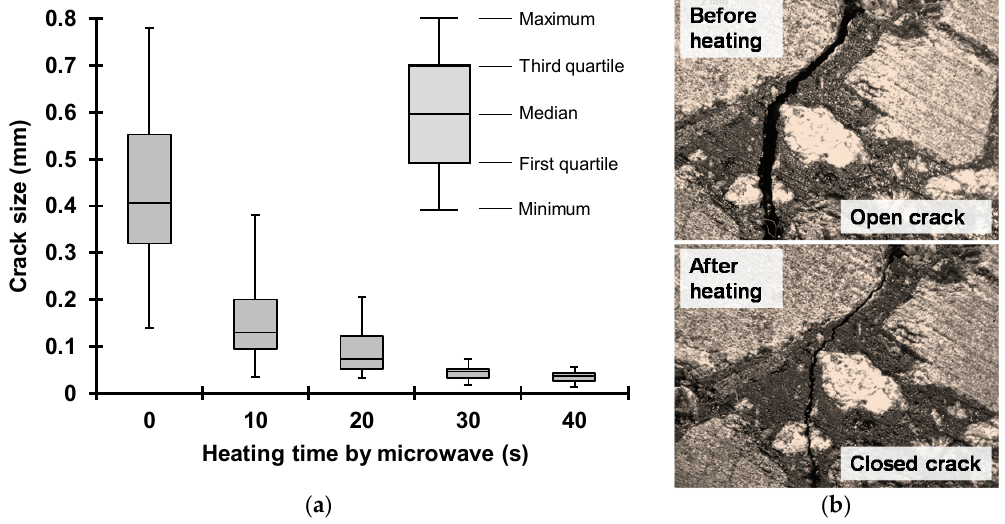
Figure 11. ( a ) Box plot representation of the crack size before healing (heating time = 0 s) and after healing of asphalt mixture samples at different heating times; ( b ) Optical images of a cracked asphalt sample before and after heating by microwave radiation at 40 s (Image dimensions are 8 × 10 mm, approximately).